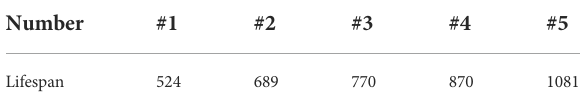
TABLE 1 Battery life data.